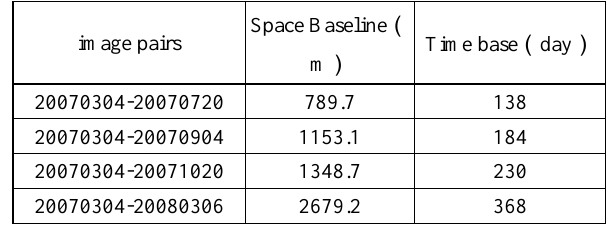
Table 1. Baseline information on the